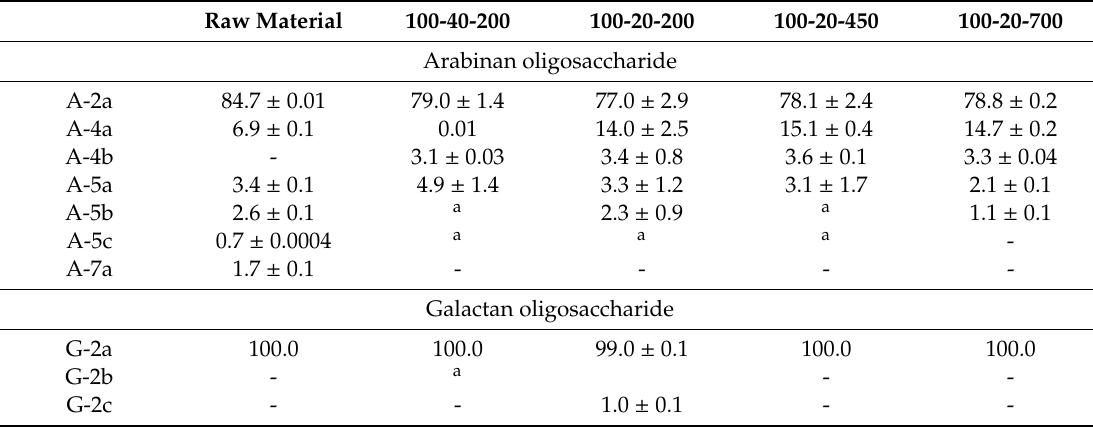
Table A6. Arabinan and galactan oligosaccharide composition (mol%) after incubation of soluble dietary fiber of raw and extruded apple pomace with endo -arabinanase and endo -galactanase (mean value ± range / 2, n =